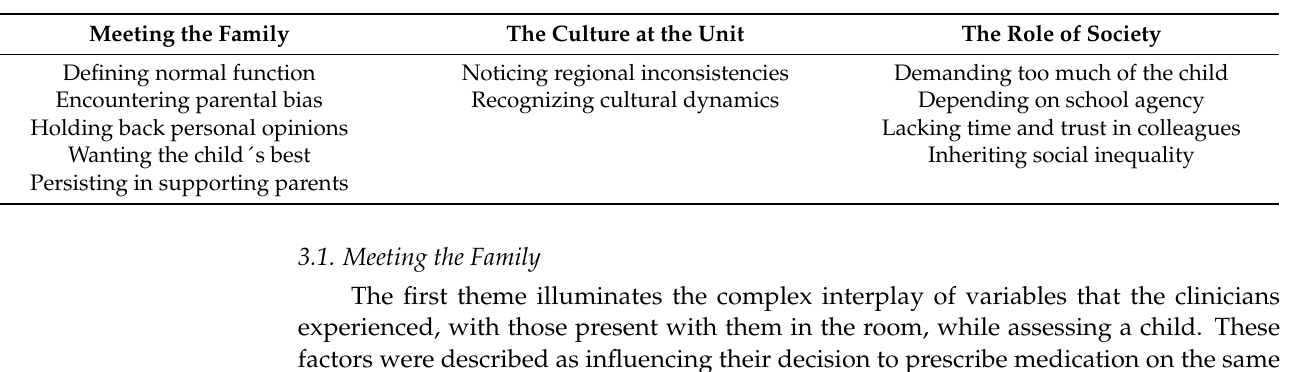
Table 1. Themes and